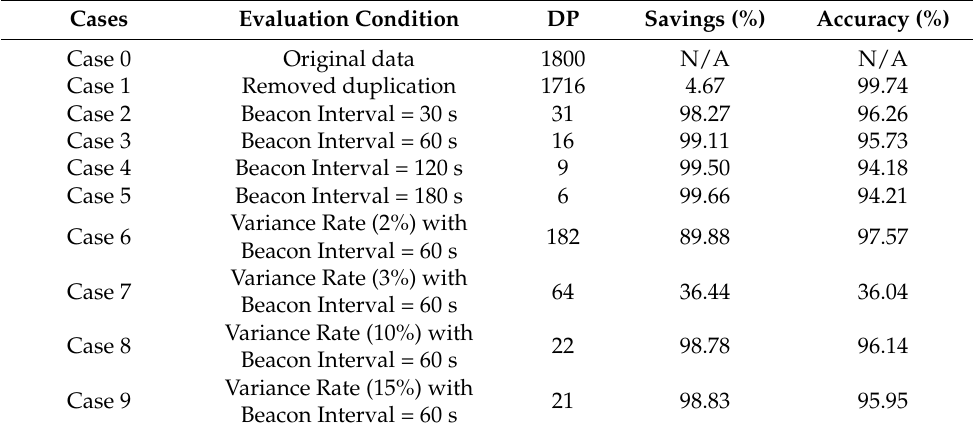
Table 1. Efficiency and accuracy evaluation for different